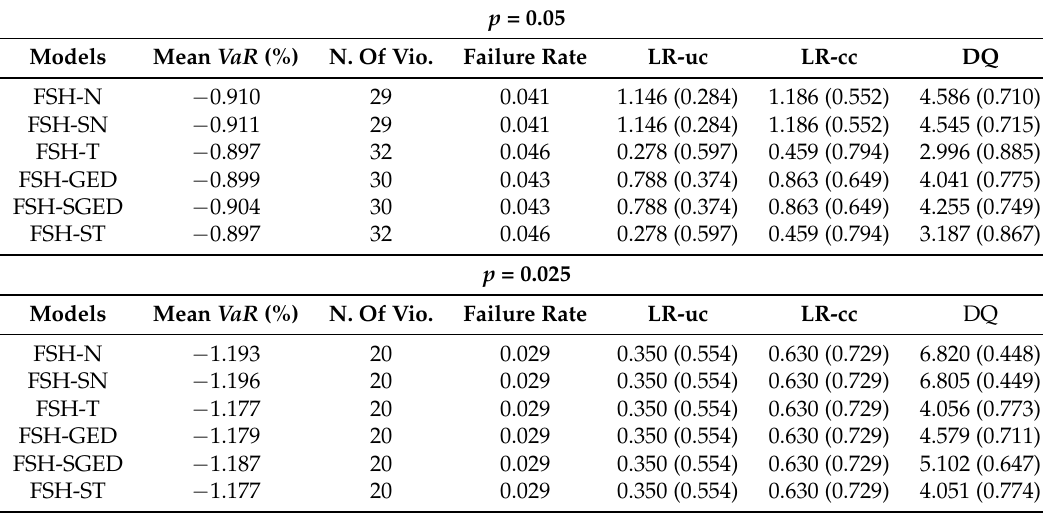
Table 3. Backtesting results of FHS models for long position ( p = 0.05, p = 0.025, and p = 0.01). p =